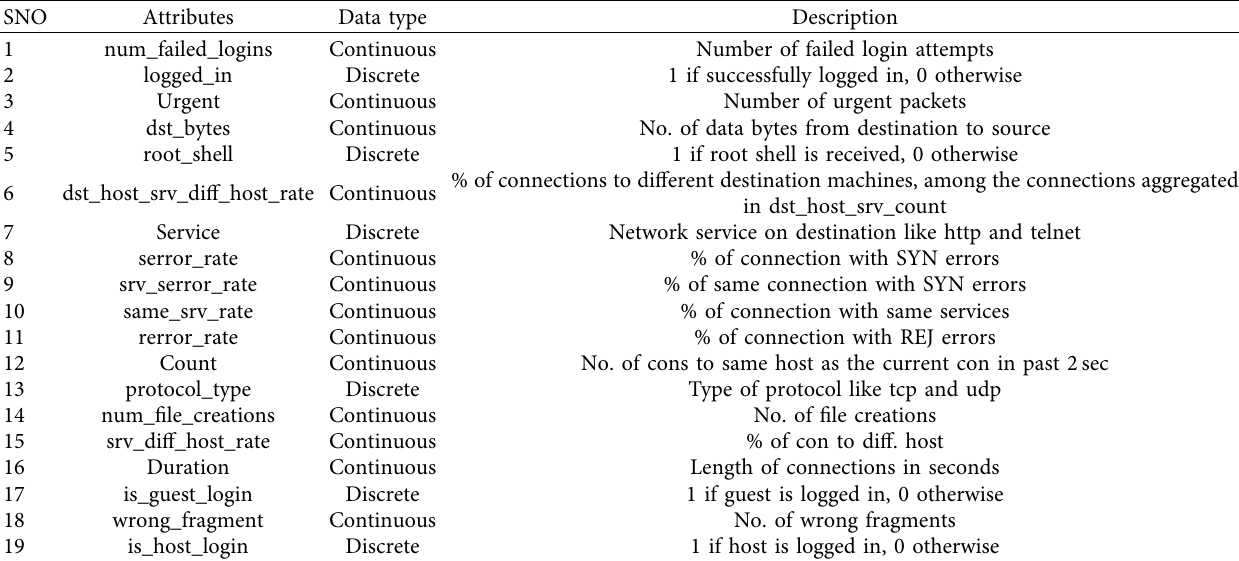
Table 1: The list of selected